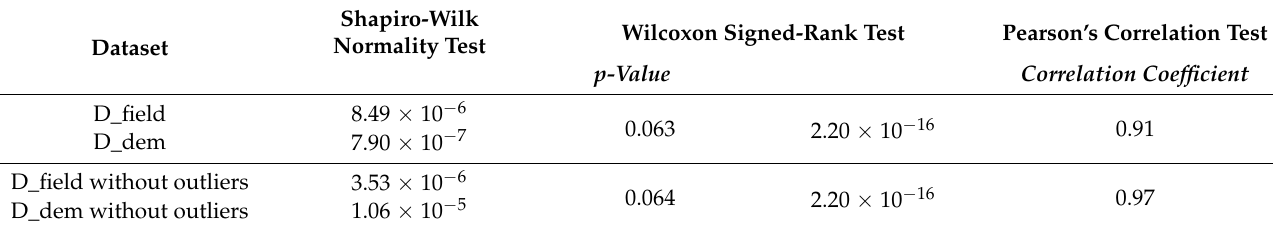
Table 4. Results of the statistical tests of the population with and without outliers.